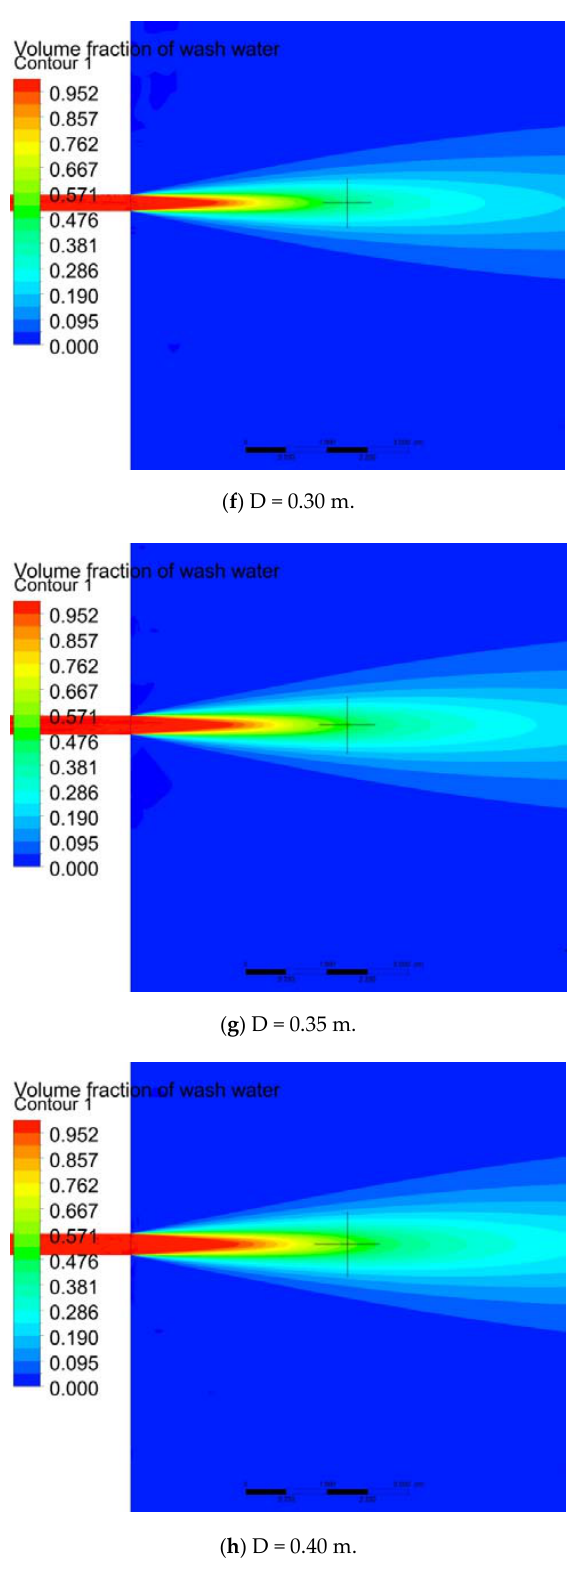
Figure A1. Volume fraction distributions of wash water under different nozzle diameters.